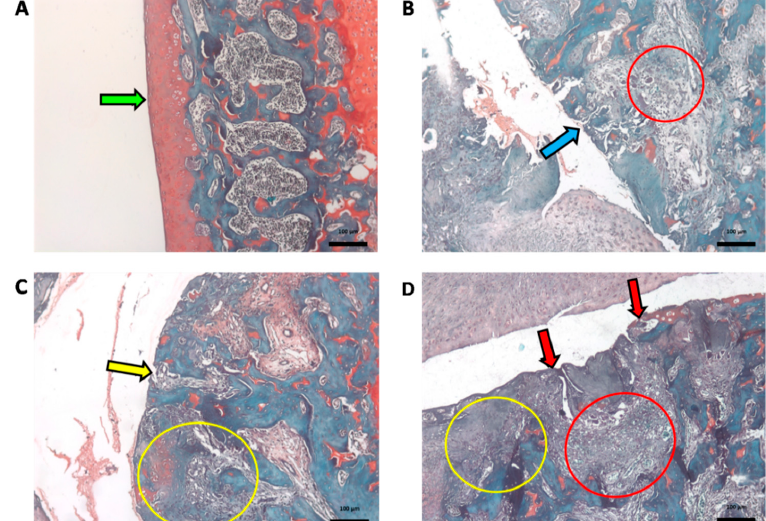
Figure 9. Sections of articular cartilage with different grades of degenerative changes in osteoarthritis (OA) classified using the Osteoarthritis Research Society International (OARSI) scoring system.This analysis was performed with the knees collected on day 29 after OA induction. ( A ) Example of CLEAN group, untreated and uninduced OA, healthy (Grade 0) normal cartilage. ( B ) Example of CTL-group treated with 0.9% saline. ( C ) Example of EHA450 group treated with A. chica hydroalcoholic extract 450 mg/kg. ( D ) Example of CTL + Melox group. B, C, and D with degrees on average between 5.4 and 5.9. Green arrow indicates normal cartilage lining (intact surface and cartilage); blue arrow indicates microfractures; red arrow indicates erosion with bone expositon; red circles indicate repair fabric; yellow arrowindicates complete erosion; yellow circles indicate fibrocartilage formation and bone remodeling. (O-safranin stain; Bar = 100 μ m; 200×). Histopathological analyses of the liver, spleen and kidney showed no pathological changes, even at the highest administered dose of A. chica extract (450 mg/kg) (Figure 10), thus demonstrating that the extract did not induce any toxicity.